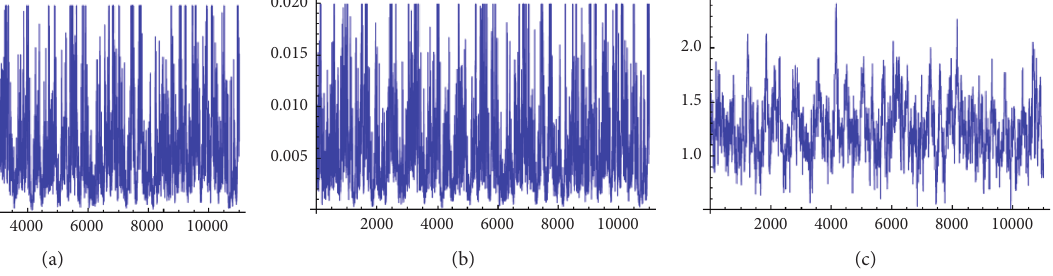
Figure 3: Simulation number generated by the MCMC method for α